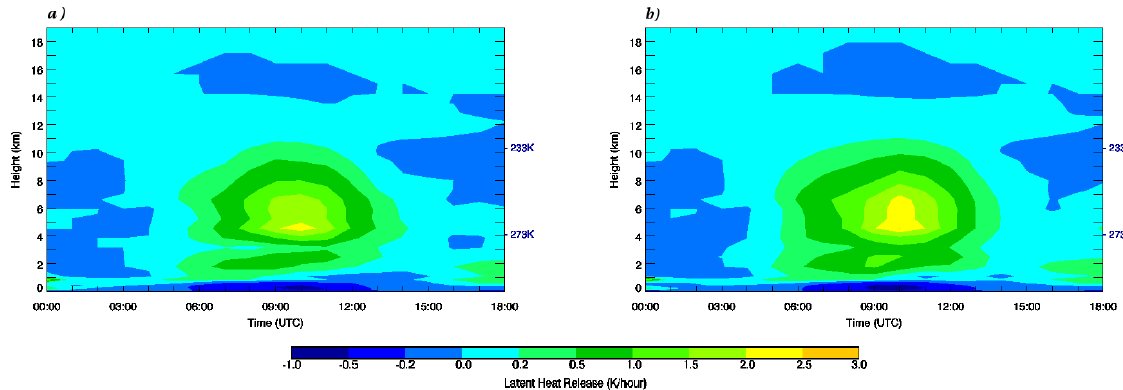
Fig. 15. Latitudinal cross section of vertical velocity at 10:00 UTC: (a) C-case and (b) P-case. 3. Replace Fig. 16 with the new one: